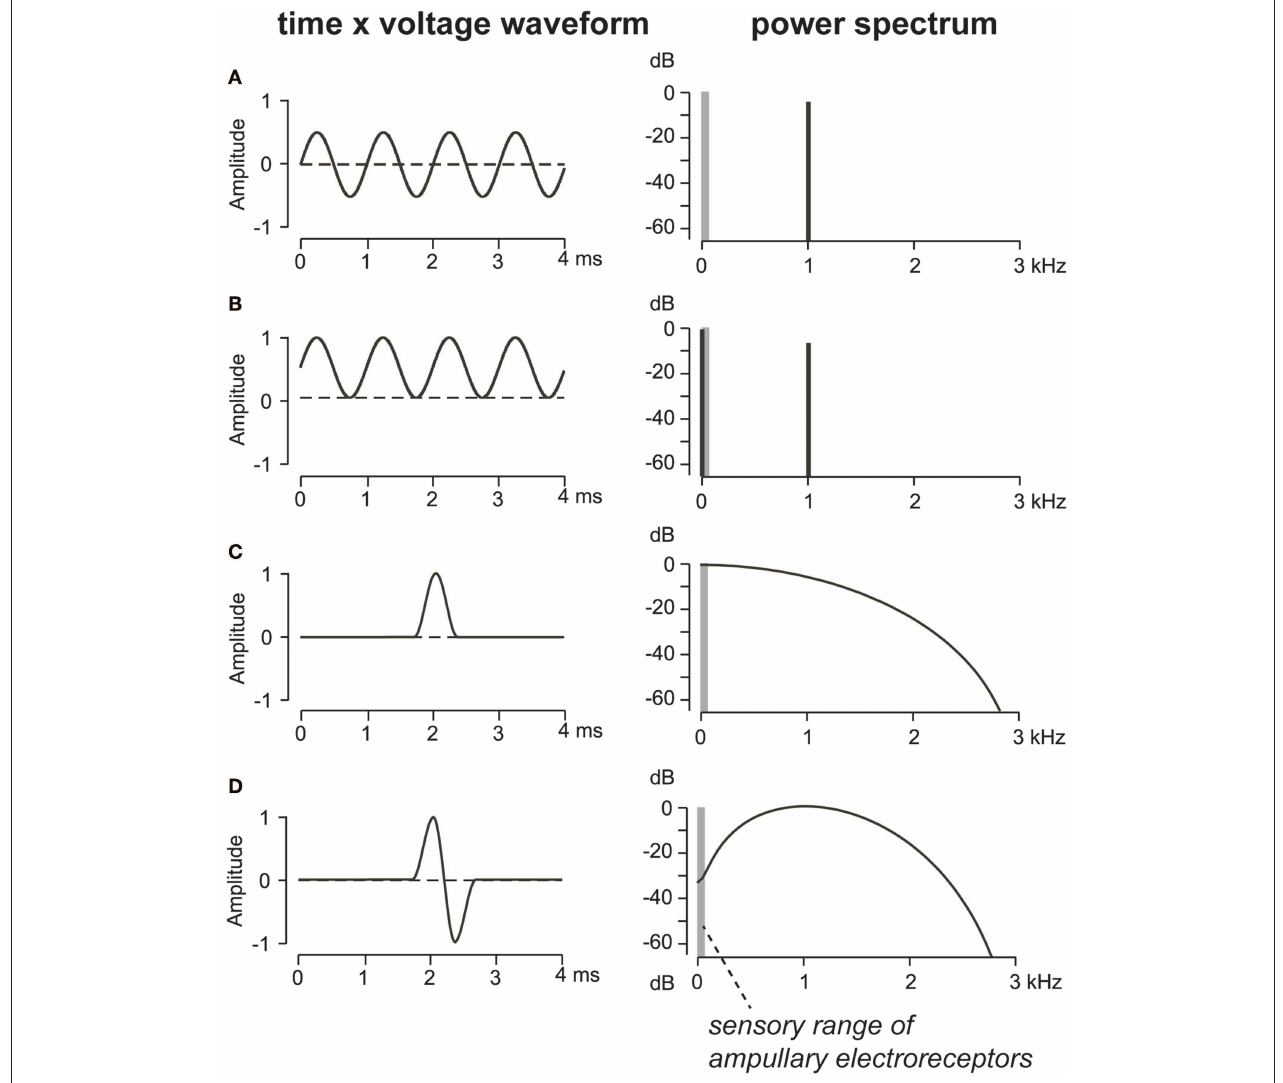
FIGURE 4 | (A) A pure 1,000Hz sine wave centered symmetrically around zero Volt amplitude has no low-frequency energy in the range of ampullary electroreceptors (vertical gray bar). (B) That same sine wave with a DC-offset has signal energy in the low-frequency range of the ampullary system. (C) An offset cosine pulse, resembling a monophasic EOD, has abundant low-frequency energy in the spectral range of ampullary electroreceptors. (D) A single-pulse sinusoid with a 1,000Hz fundamental frequency has a much broader spectrum than the continuous sine wave, but does show some suppression of low-frequency energy. Adapted